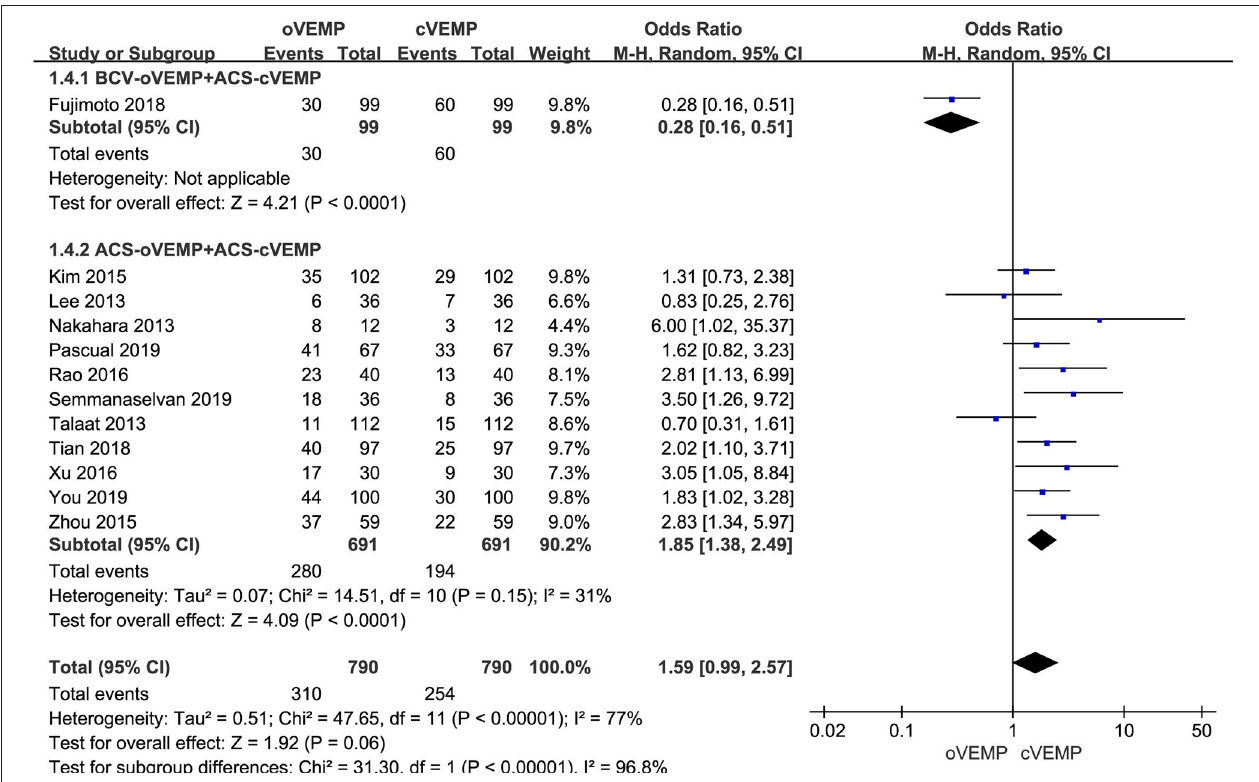
FIGURE 2 | Meta-analysis of abnormal rate of vestibular evoked myogenic potential (VEMP) in benign paroxysmal positional vertigo (BPPV) patients based on sound stimuli.